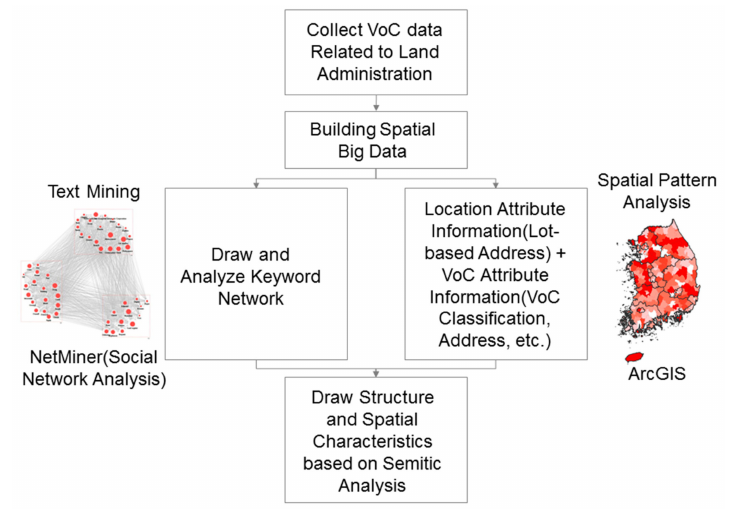
Figure 2. Research process.